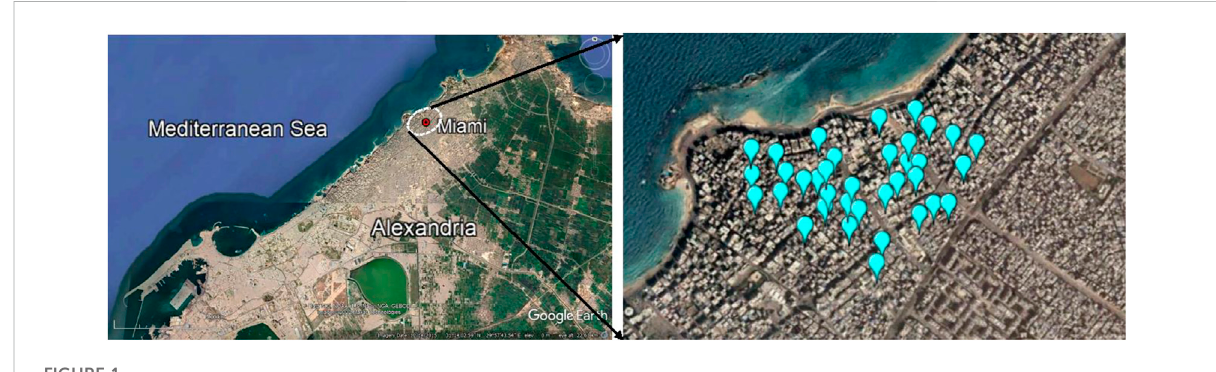
FIGURE 1 Location of the monitoring